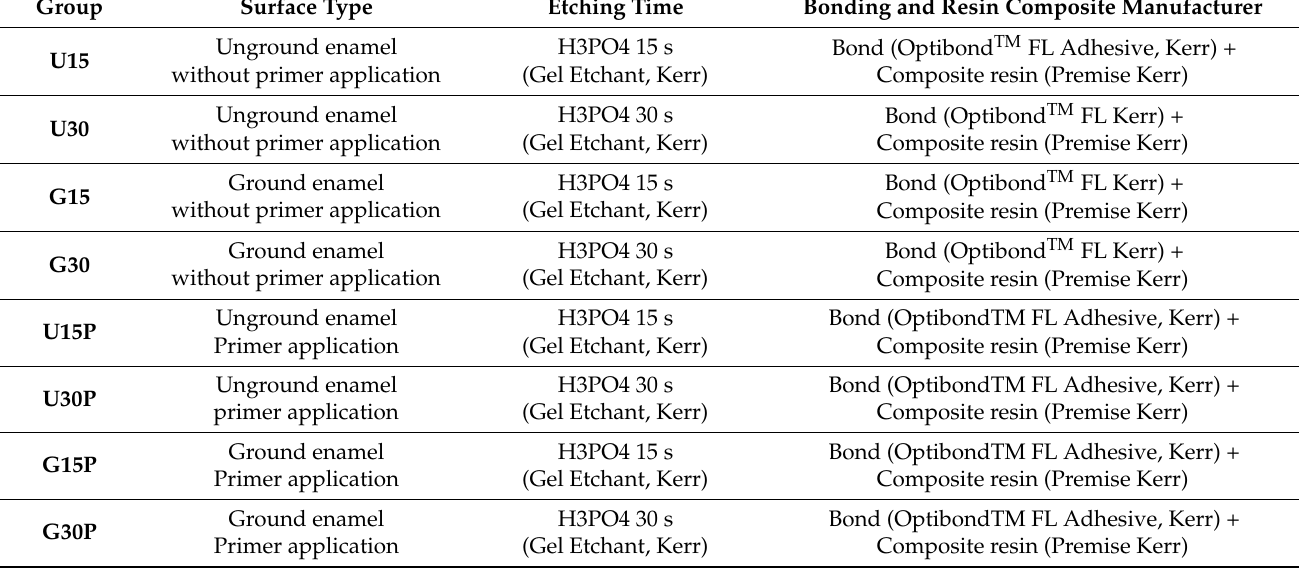
Table 1. Experimental group details and materials employed.